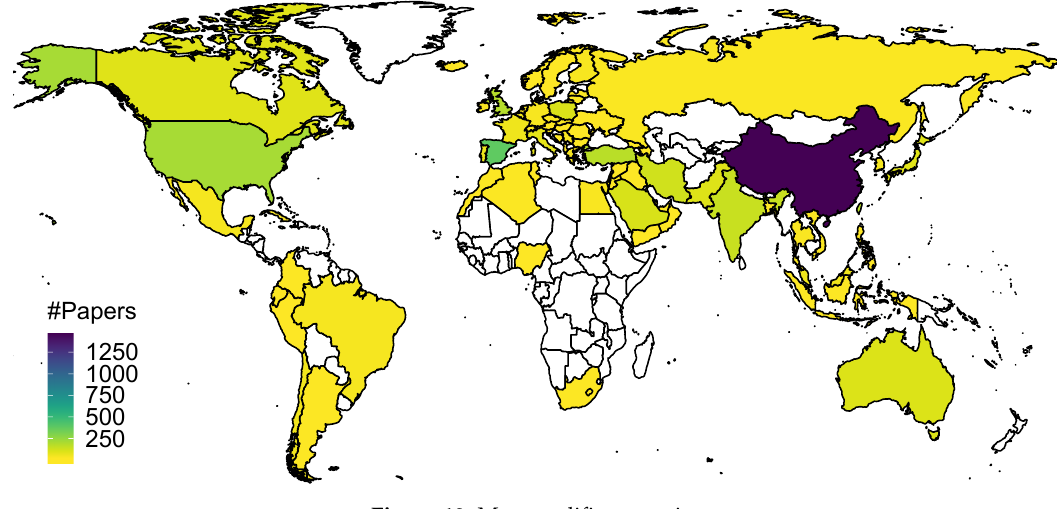
Figure 10. Most prolific